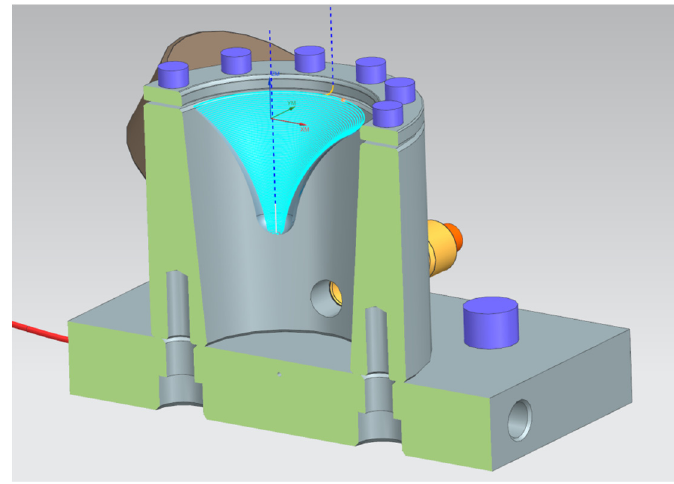
Figure 3. Toolpath trajectory generated in NX CAM software.